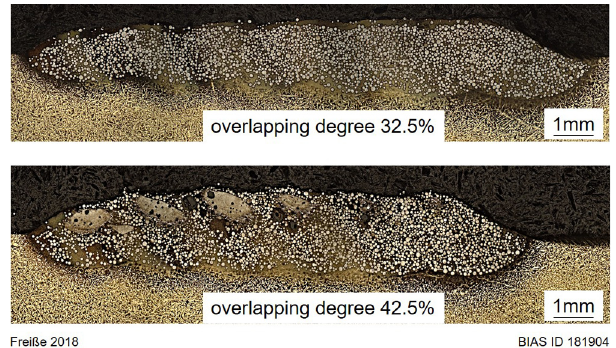
Fig. 8. Metallographic image of laser melt-injected multitracks with a change in track geometry depending on the overlapping degree.